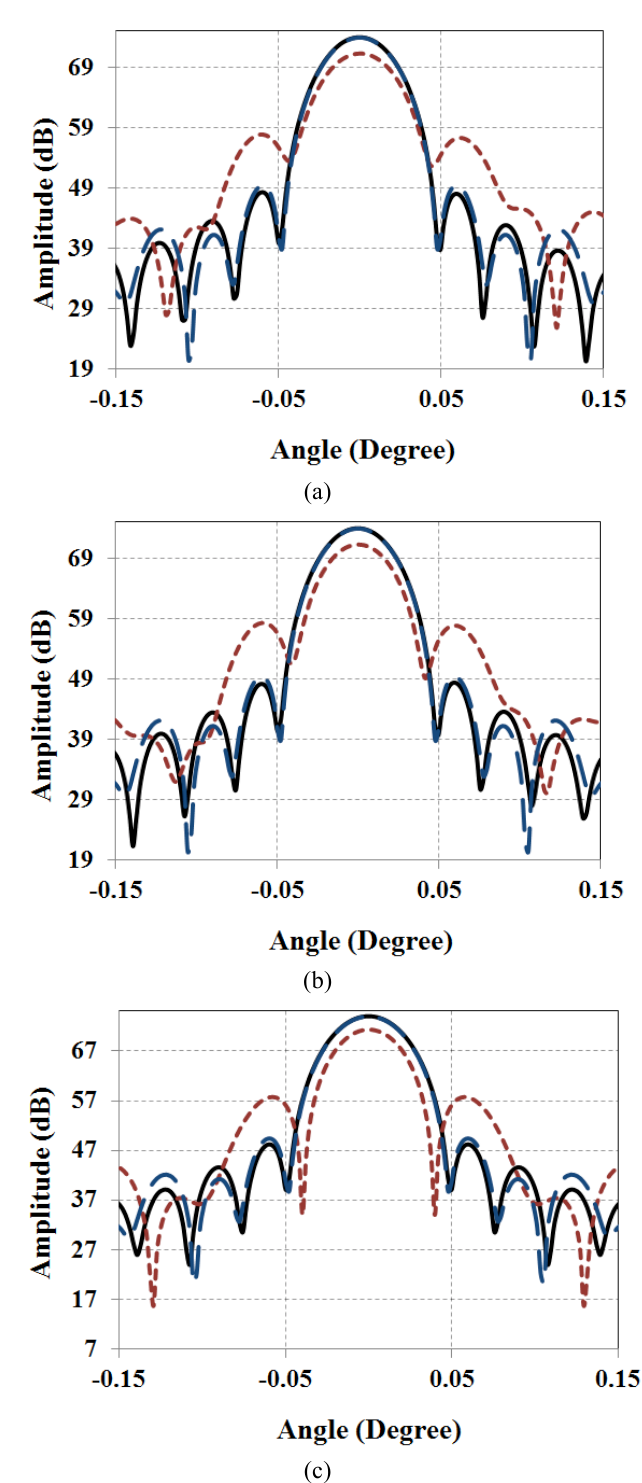
Figure 7: The beam patterns of offset (solid lines), on-axis (dashed lines) and off-axis (dotted lines) Cassegrain antenna, at f = 45 GHz and φ = (a) 0º , (b) 45º and (c) 90º